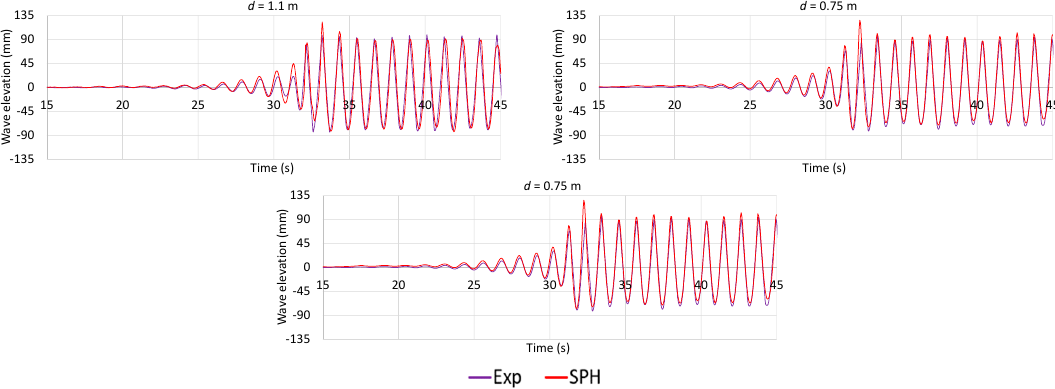
Figure 9. Comparison of wave elevation for A = 50.5 mm and T = 1.15 s with three water dept.